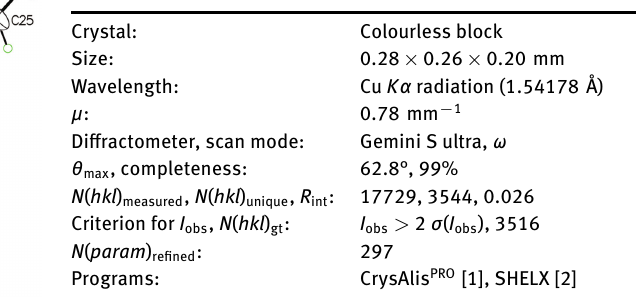
Table 1: Data collection and handling.